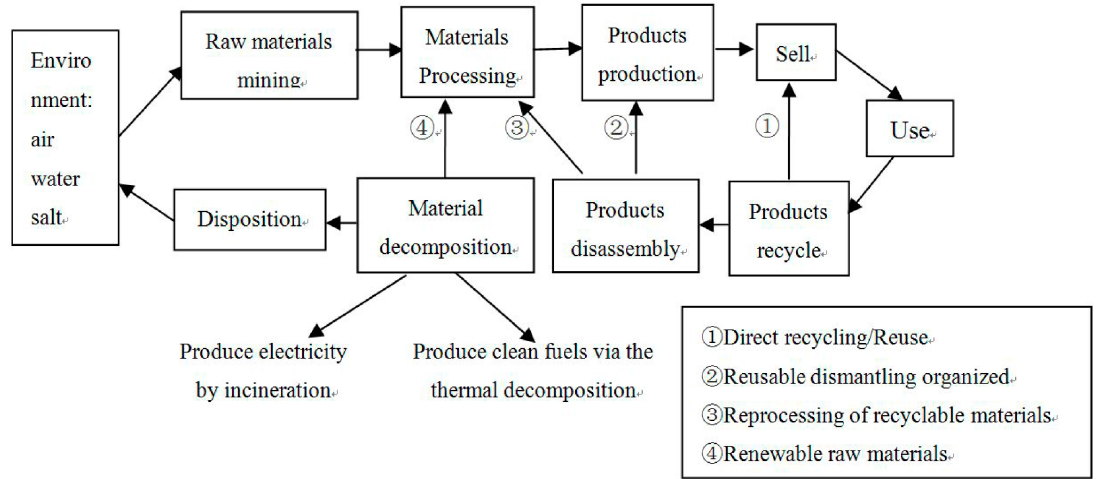
Figure 2. Resources flow route under an